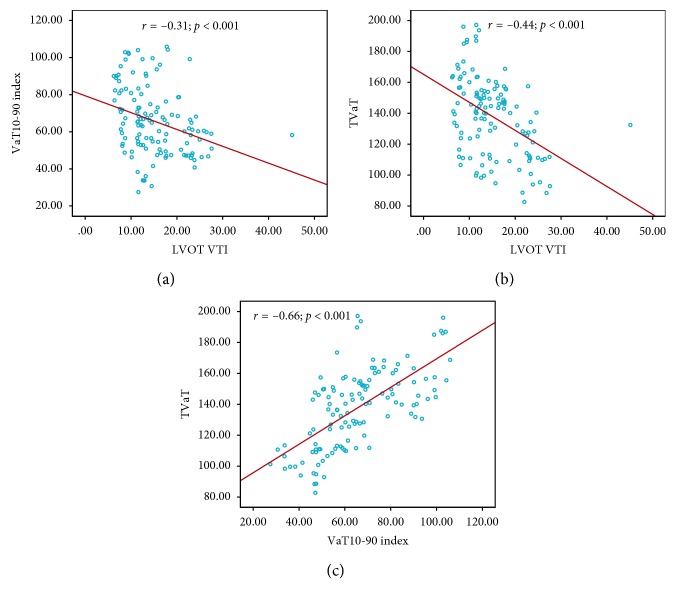
Correlations among LVOT VTI, TVaT, and VaT10-90. LVOT VTI, left ventricular outflow tract velocity time integral; TVaT, total ventricular activation time; VaT10-90, ventricular activation time10-90. Pearson correlation; p < 0.001 for LVOT VTI/TVaT and LVOT VTI/VaT10-90.